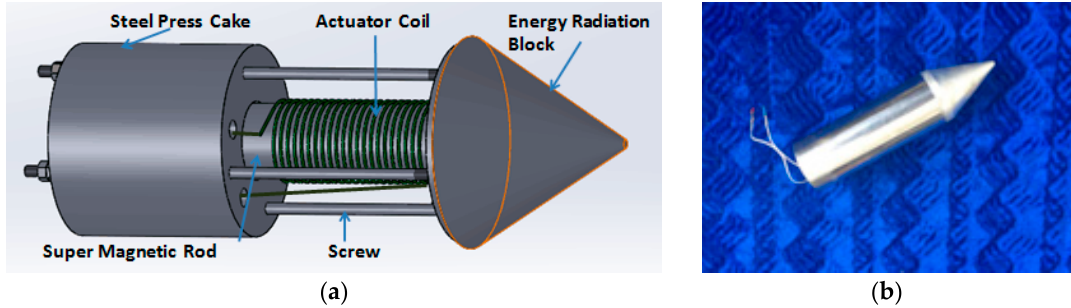
Figure 2. Illustration and photograph of the GMS transducer: ( a ) components of the GMS transducer; and ( b ) photo of the GMS transducer.